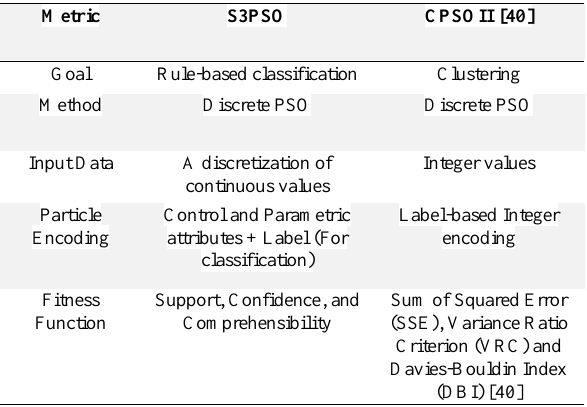
Figure 2. General process of the proposed S3PSO method. Table 3. Comparison between S3PSO and CPSOII